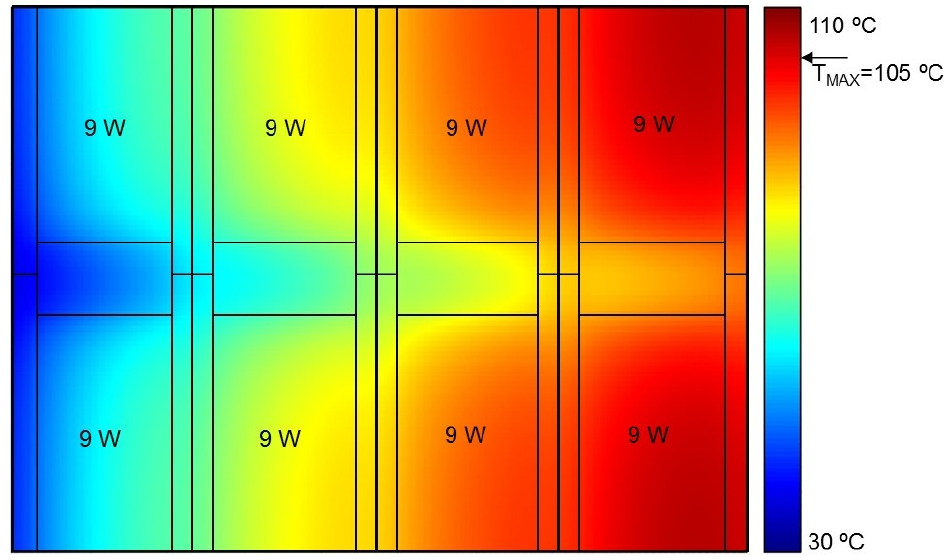
Figure 9. Temperature map of the middle layer of the simulated 3D processor (default case) where powers dissipated in all cores are the same. The powers dissipated in other processor units are listed in Table 2. The inlets are located on the left side of the chip.